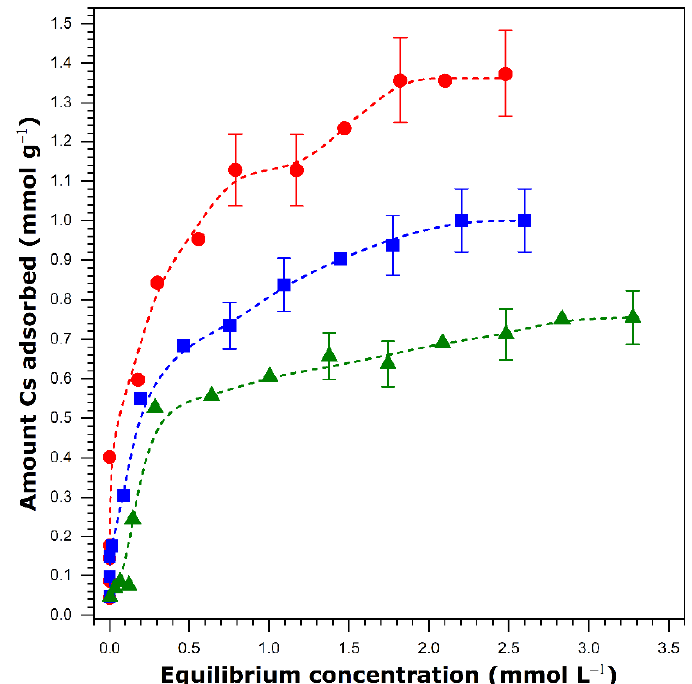
Figure 9. Sorption isotherms for cesium ions onto VO x -E1 sample from single solute solutions (red circles) and multicomponent aqueous solution corresponding to the Ca-rich mineral water (blue squares) or simulated sea water (green triangles). The error bars represent, for selected points, the maximum percentage error in the sorption experiments. The dashed lines are drawn to guide the eye.